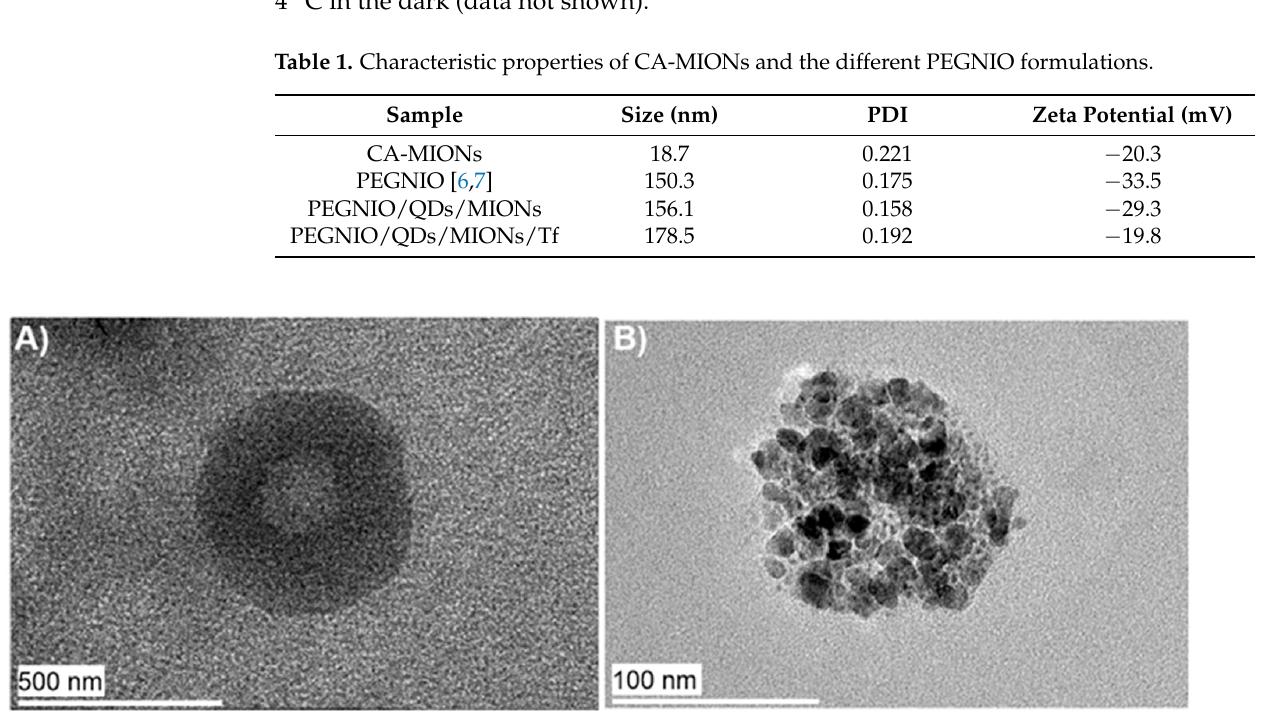
Figure 2. TEM images of PEGNIO/QDs/MIONs obtained at 120 keV ( A ) and at 200 keV ( B ). Additionally, the sample was diluted in cell culture media and was incubated at 37 ◦ C for 24 h. The size of the sample was measured before and after incubation, and no changes were observed. The photometric characteristics of InP/ZnS QD after encapsulation